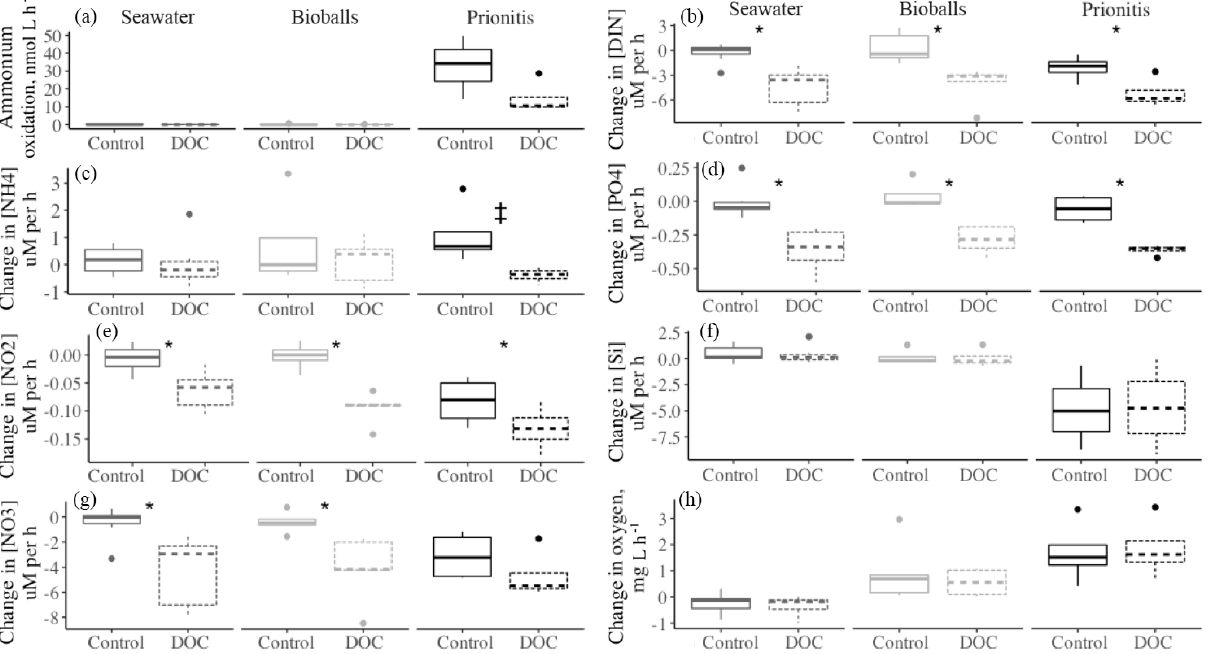
Figure 4. The effect of supplemental DOC on (a) the rate of ammonium oxidation (in nmolL − 1 h − 1 ), (b–g) the change in nutrient concen- trations (µMh − 1 ), and (h) the oxygen concentration (in mgL − 1 h − 1 ). An * indicates a significant difference ( p< 0 . 05) between the control and the DOC addition for seawater alone, seawater with bioballs, or the red alga Prionitis . Double dagger indicates 0 . 10 >p< 0 . 05. Boxplots as in Fig.